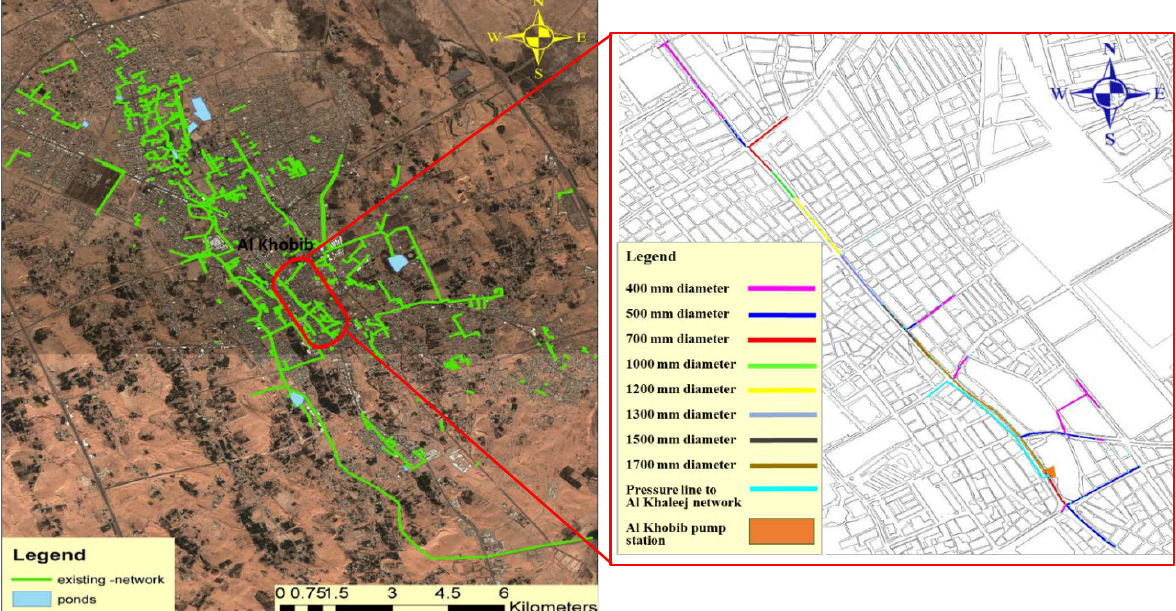
Figure 13. Existing storm sewerage network